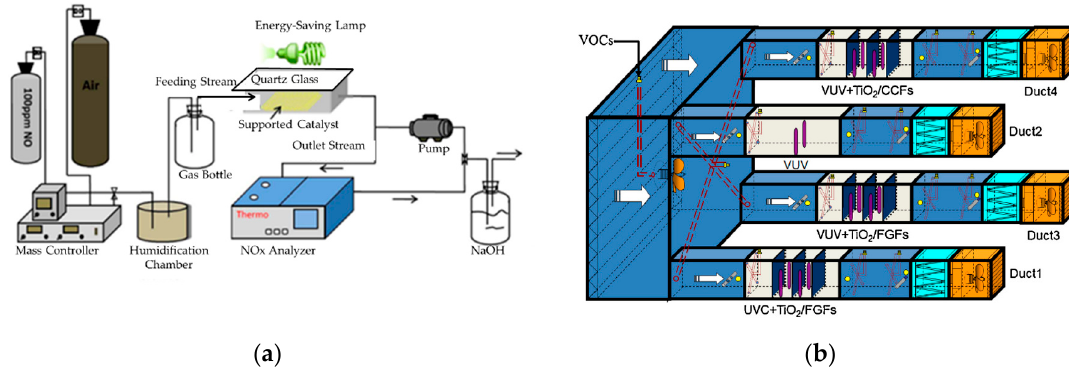
Figure 9. Schematic flow diagram of the customized experimental setup for: ( a ) NO degradation under visible light (adapted with permission from Reference [80], Copyright (2005), American Chemical Society), and ( b ) VOC removal under VUV (vacuum ultraviolet) irradiation (reprinted from [79], Copyright (2013), with permission of Elsevier).